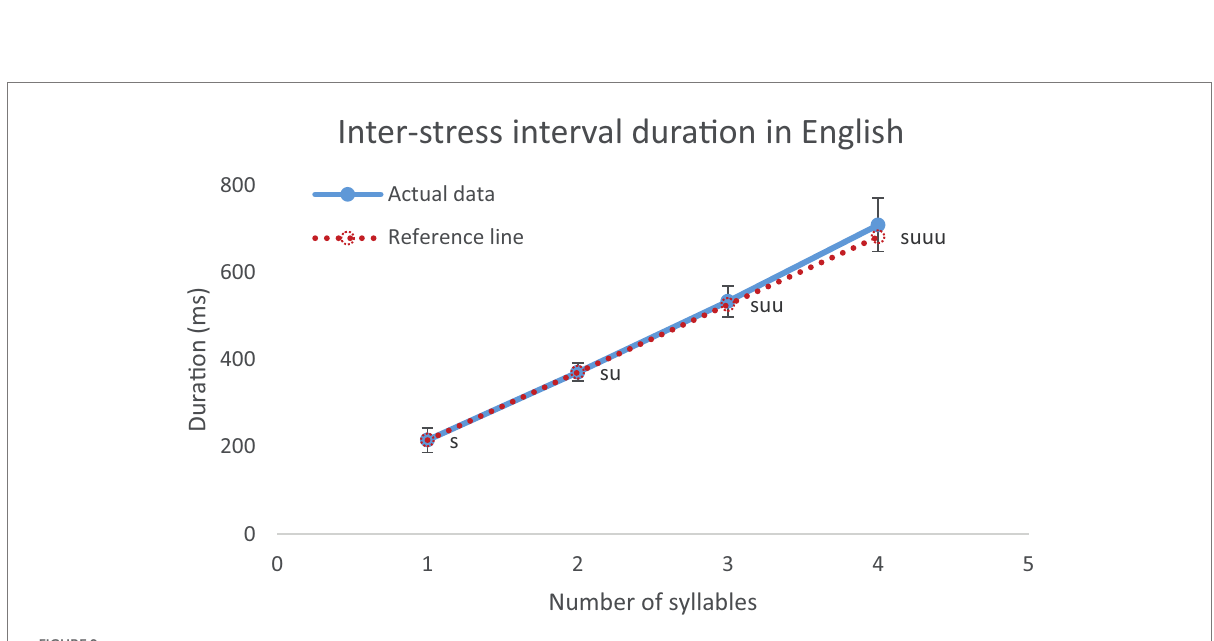
FIGURE 9 Average inter-stress interval durations in seconds, s indicates a stressed syllable and u indicates an unstressed syllable. On the reference line, the leftmost point shows the duration of monosyllabic stressed syllable, while the rest of the points shows the same increment of the unstressed syllable in disyllabic